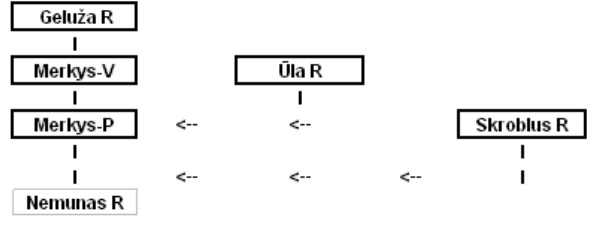
Fig. 2. Connectivity of